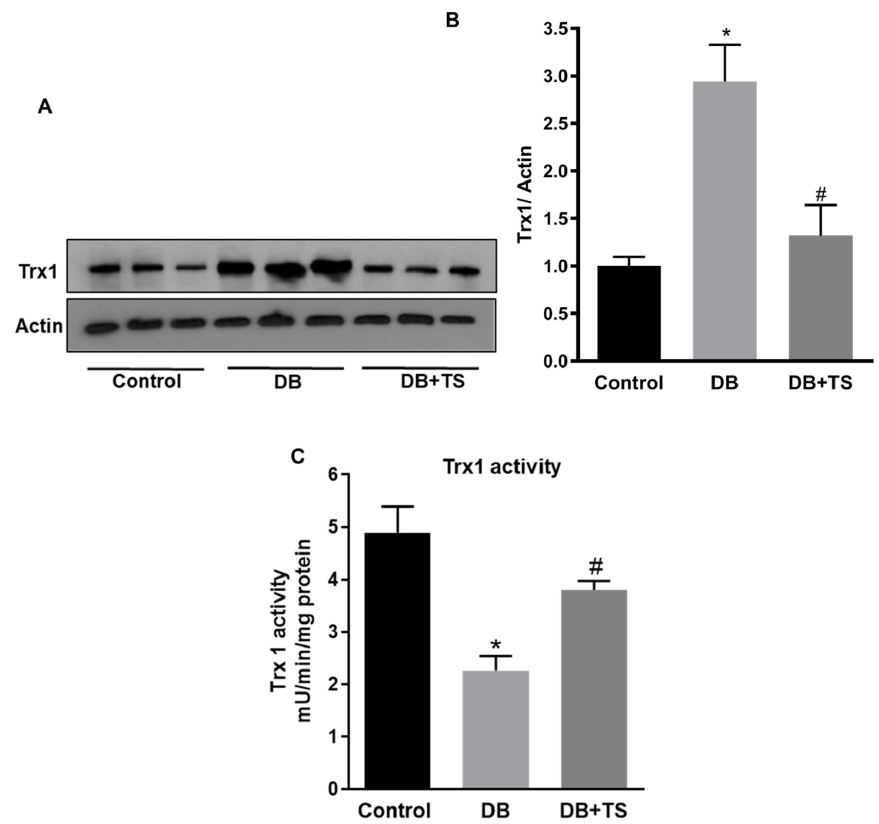
Figure 6. E ff ect of Tubastatin A on thioredoxin-1 expression and activity. ( A ) Western analysis of thioredoxin-1 (Trx-1) protein expression measured in retinas of STZ-rats (DB), STZ-rats receiving TS (10 mg / kg) (DB + TS) and normoglycemic control rats (control). ( B ) Quantification of optical density of Trx-1 immunoblotting normalized versus actin. ( C ) Trx-1 enzymatic activity measured in STZ-rats (DB), STZ-rats treated with TS (10 mg / kg) (DB + TS). Values are mean ± SEM for n = 6. * p < 0.01 vs. control and # p < 0.01 vs.